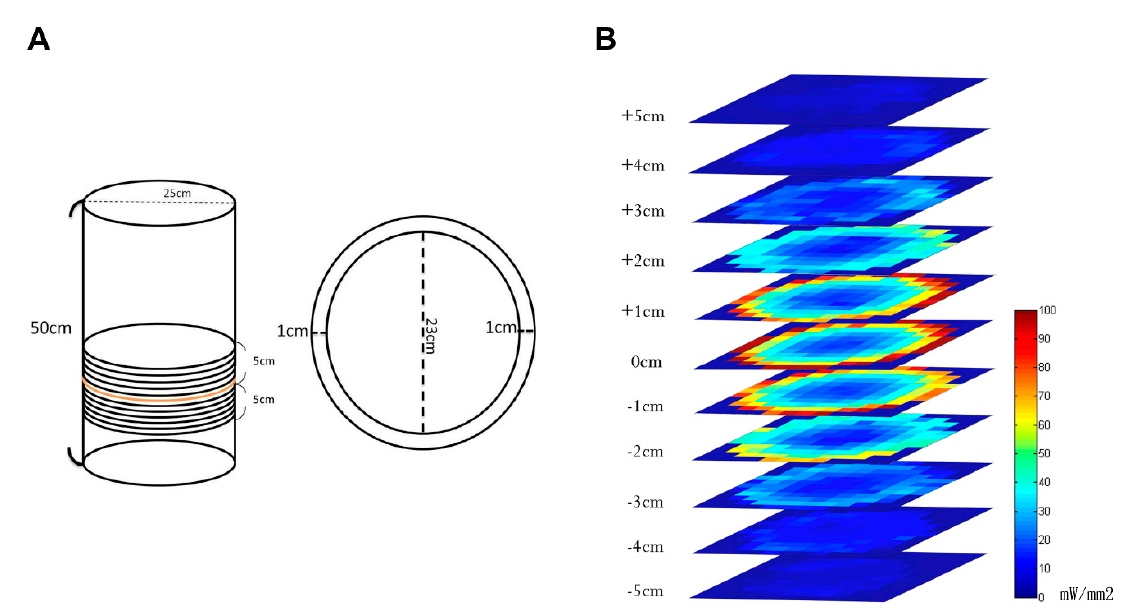
Figure 3. Color mapping for the electromagnetic field. ( A ) The electromagnetic field was composed of a plastic enclosure, a source coil, and a flexible ground. ( B ) For the electromagnetic resonance of the wireless remote-controlled device, the electromagnetic field is shown via color mapping.